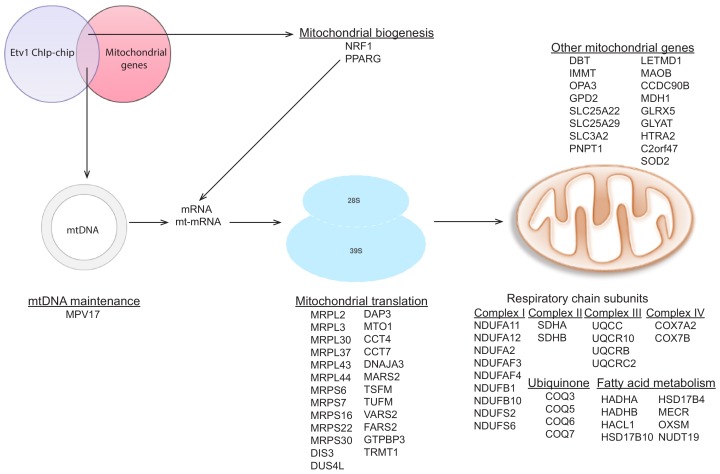
Targets of ETV1 as determined by ChIP-ChIP data analysis.Analysis of publicly available ETV1 ChIP-ChIP dataset with the same approach described in Figure 4—figure supplement 4 above, shows several mitochondrial genes as targets of ETV1. Schematic representation of these genes also includes NRF1 and PPARG as ETV1 target genes.